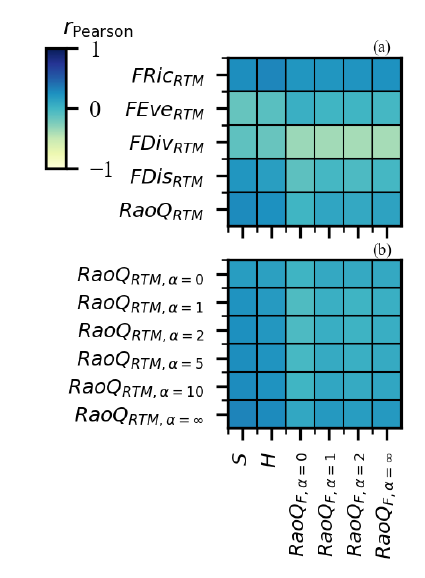
Figure 4 . Pearson correlation between field and remote sensing (parameter estimate-based) metrics. Asterisks indicate 323 significant relationships at 95 % of